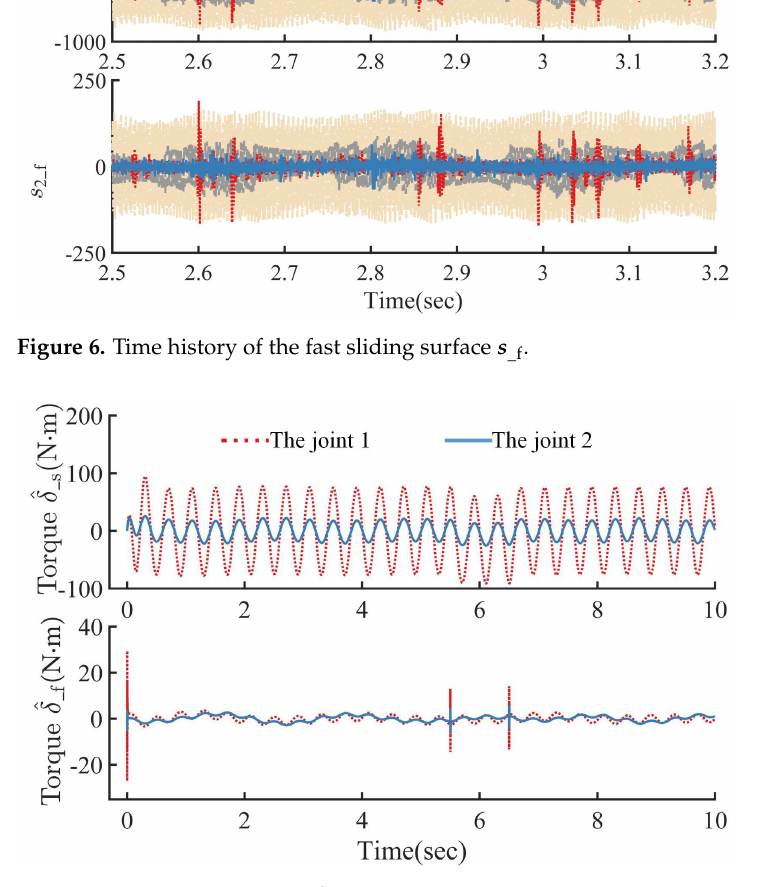
Figure 7. RBF compensation of torque